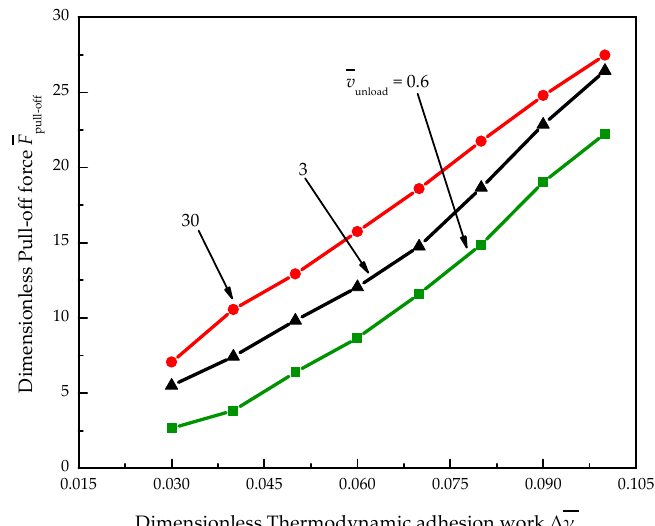
Figure 10. The effect of thermodynamic adhesion work on pull-off force under the condition of 𝛿̅ max = 2.49.